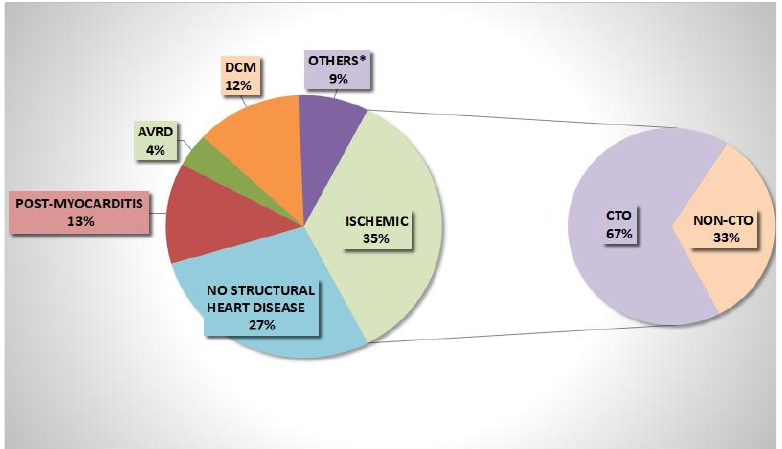
Figure 1. Underlying heart diseases on admission. Others *: hypertrophic cardiomyopathy, grown-up congenital heart disease, valvular heart disease.